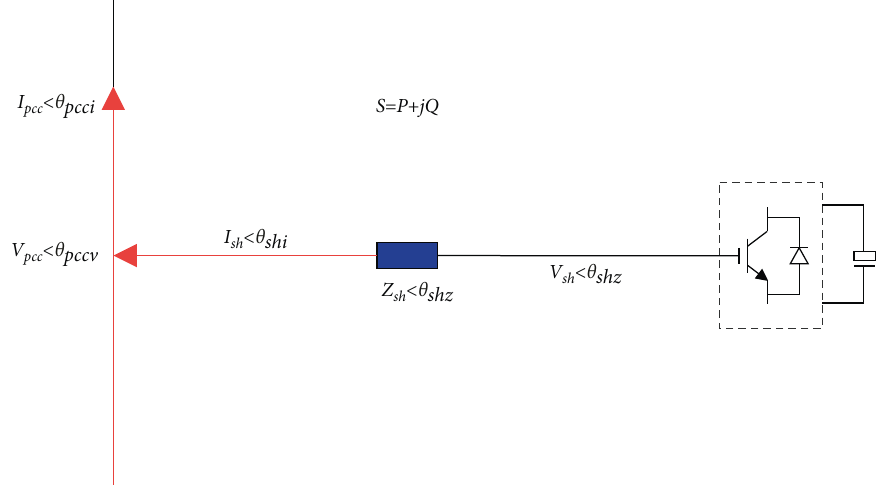
Figure 1: Single-phase phasor diagram of grid-connected APF